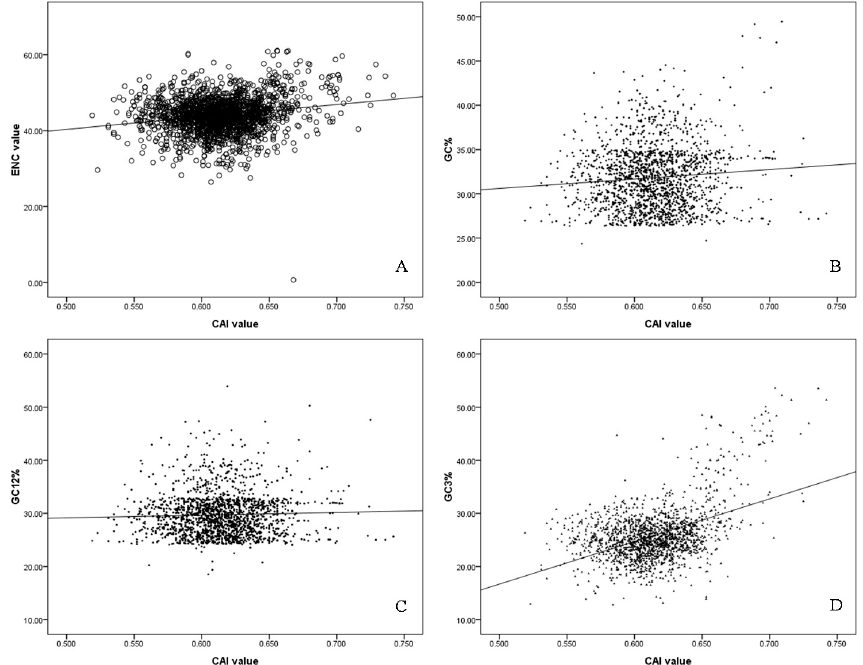
Figure 4. The correlation between CAI values and ENC, GC%, GC12%, GC3% values. ( A ) the correlation between CAI values and ENC values, the black dot represented the ENC value against CAI value for each gene, the black line was generated by the correlation analysis; ( B ) the correlation between CAI values and GC% values, the black dot represented the GC% value against CAI value for each gene, the black line represented linear fitting line of all data; ( C ) the correlation between CAI values and GC12% values, the black dot represented the GC12% value against CAI value for each gene, the black line represented linear fitting line of all data; ( D ) the correlation between CAI values and GC3% values, the black dot represented the GC3% value against CAI value for each gene, the black line represented linear fitting line of all data.